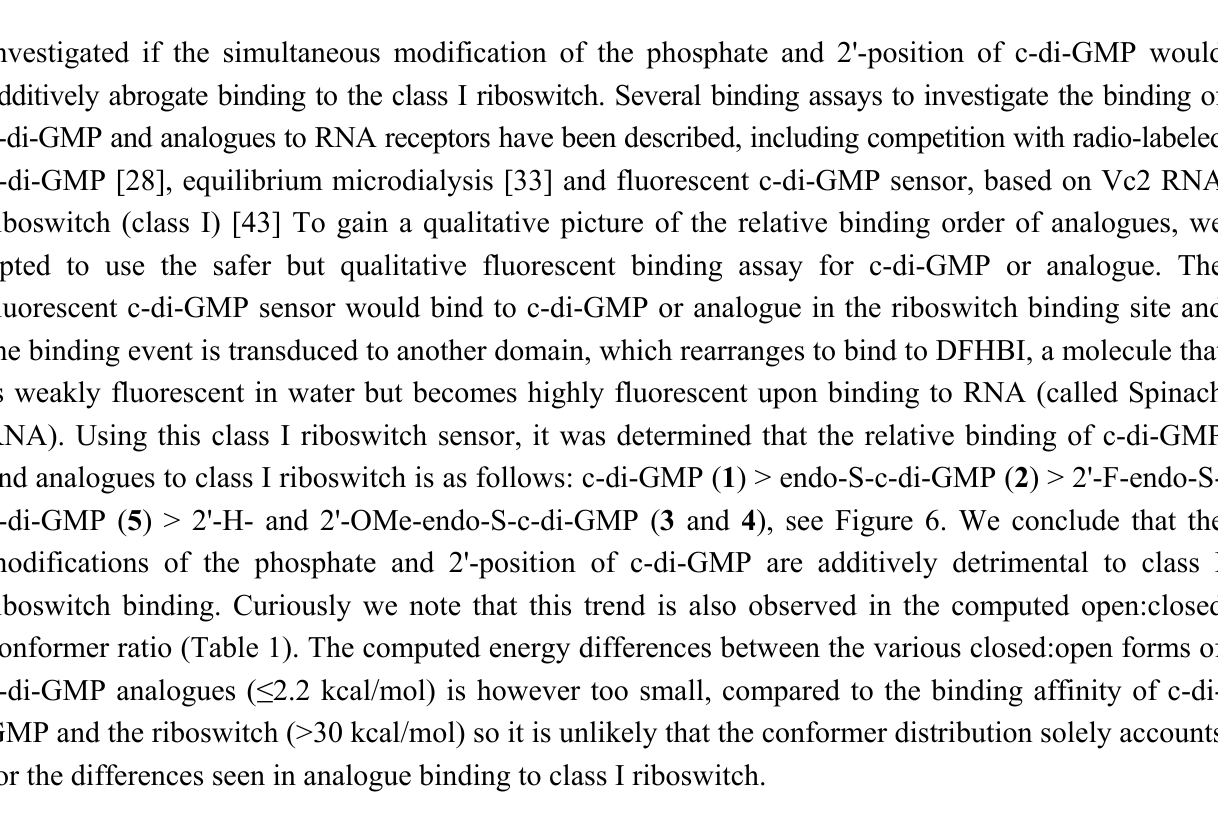
Figure 6. Differential binding of endo-S-c-di-GMP analogues to fluorescent Vc2 RNA riboswitch [43]. Conditions: [RNA, SP_2] = 1 µM, [c-di-GMP and/or analogues] = 10 µM. Buffer: 100 mM HEPES (pH 6.8) containing 100 mM NaCl, 100 mM KCl and 6 mM MgCl